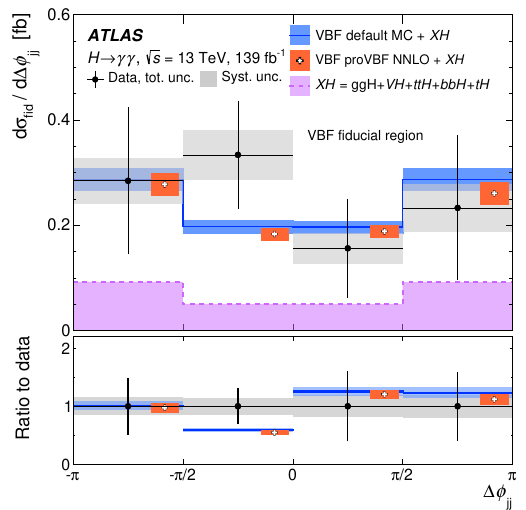
Figure 15. Particle-level fiducial differential cross-sections times branching ratio for ∆ φ jj in the VBF-enhanced fiducial